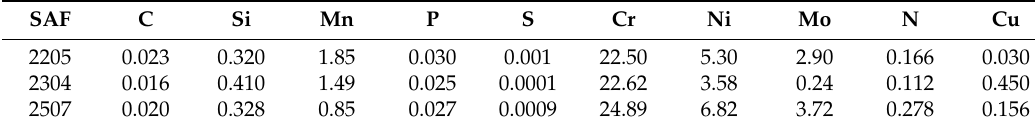
Table 1. Chemical Composition of Duplex Stainless Steel (DSS) and Superduplex Stainless Steel (SDSS) (wt